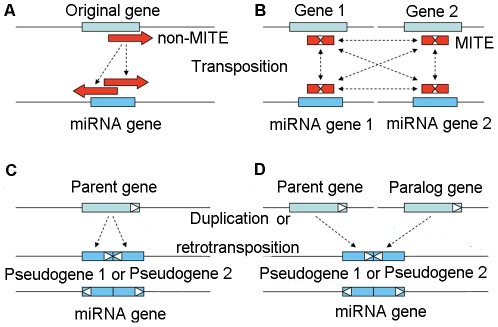
Schematic illustrations of the proposed de novo origin mechanisms of miRNA genes.(A) Mechanism of miRNA gene de novo originated from non-MITE transposable element. (B) Mechanism of miRNA gene de novo originated from MITE. (C) Mechanism of miRNA gene de novo originated from pseudogenes arose from one parent gene. (D) Mechanism of miRNA gene do novo originated from pseudogenes arose from one parent gene and its paralogous gene.